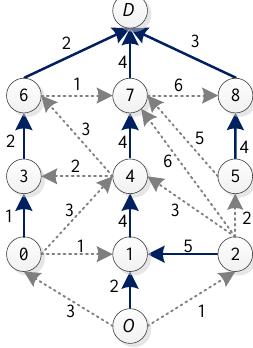
Figure 1. The shortest path